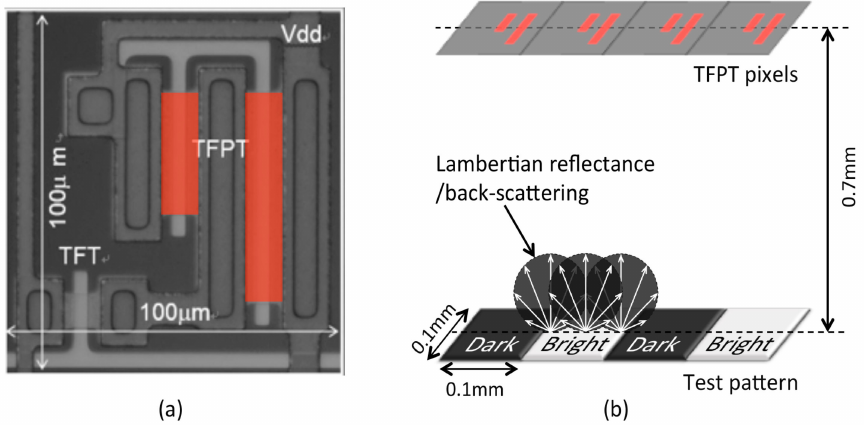
Figure 1. ( a ) Microscope image of a thin film photo-transistor (TFPT) pixel structure with the active part highlighted in red; ( b ) A sketch of the TFPT imager imaging an object with a Lambertian